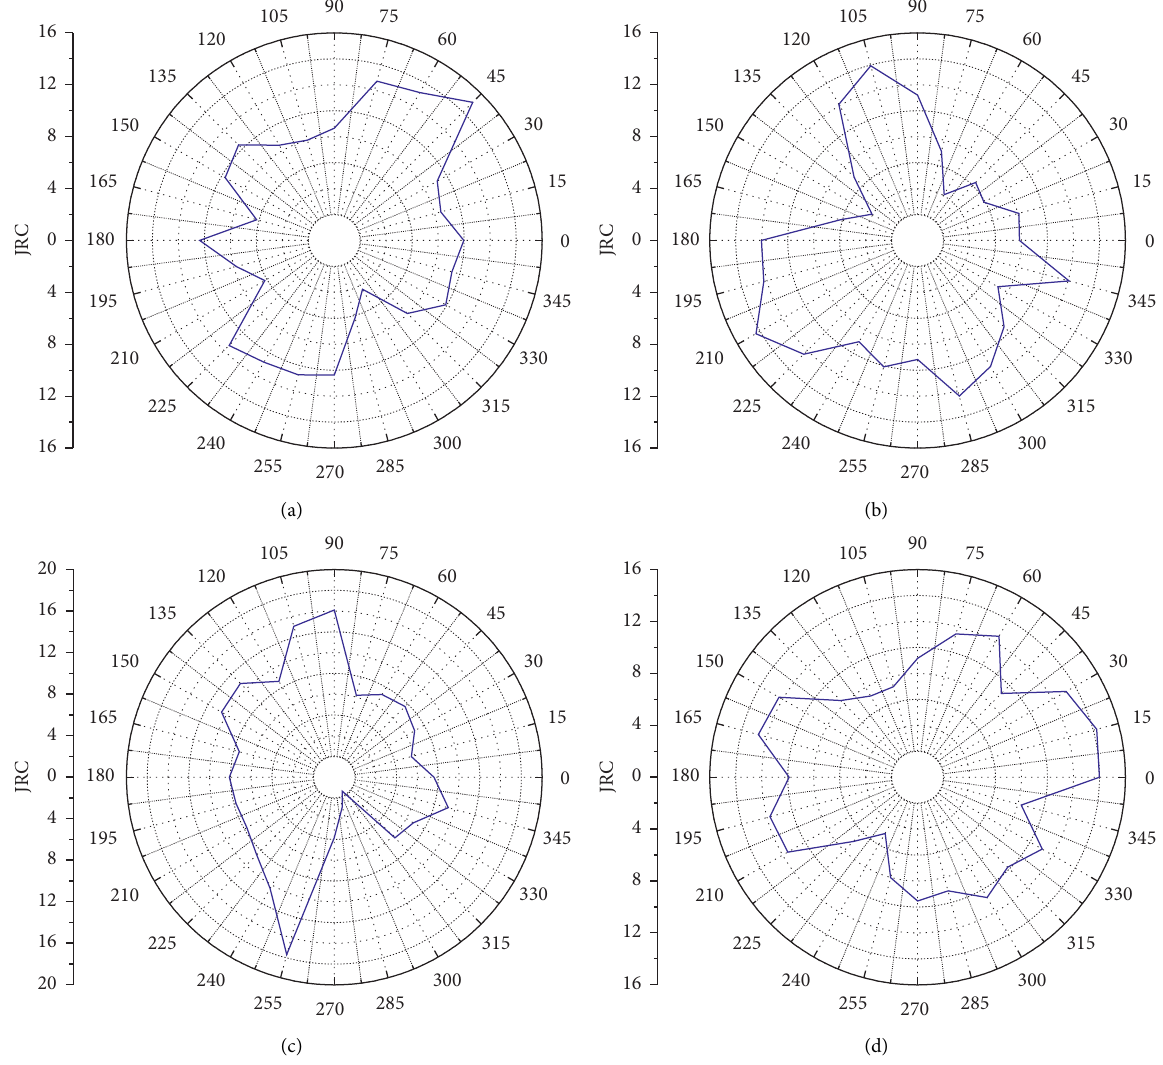
Figure 14: The JRC evaluation results of 4 joint surfaces in different directions. (a) Joint J-1. (b) Joint J-2. (c) Joint J-3. (d) Joint